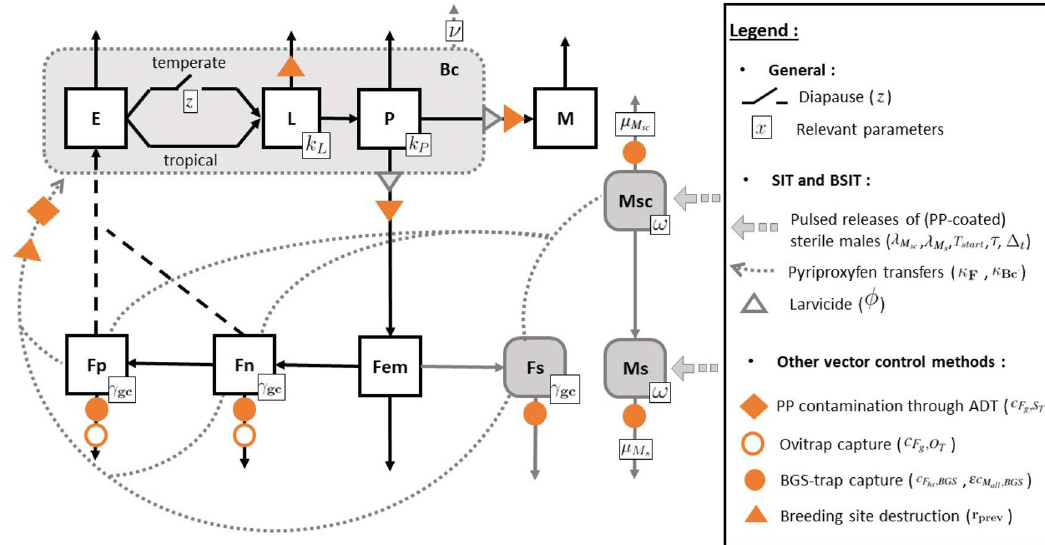
Figure 1. Simplified diagram of the model. The Aedes albopictus life cycle is computed in 7 stages: 3 are aquatic stages present in the breeding sites, eggs ( E ), larvae ( L ) and pupae ( P ), 4 are adult aerial stages, males ( M ), emerging females ( F em ), nulliparous females ( F n ) and parous females ( F p ). Black arrows indicate transitions between stages. Diapause only occurs in the temperate climate and depends on the z parameter. Changes resulting from SIT and BSIT are indicated by grey lines and boxes representing sterile males, whether PP-coated ( M sc ) or not ( M s ), sterile females ( F s ) and contaminated breeding sites ( B c ). The key parameters, in particular those affected by vector control actions, are: k L and k P respectively the larval and pupae carrying capacities, γ gc the duration of the gonotrophic cycle, ω the relative competitiveness of sterile males, µ M and µ M the mortality sc s of sterile males, respectively PP-coated or not, ν the breeding site PP decontamination rate, and φ the probability for PP-exposed larvae to survive and pupate. Additional vector control actions were added to the model (orange): mass trapping (full circles for BGS-traps and hollow circles for ovitraps) according to the probability of , ǫ c capture (respectively c F M all , BGS and c F g , O T ), prevention (triangles) by reduction of breeding sites ( r prev ), hs , BGS and PP autodissemination (diamonds for ADT) which depends on females contamination ( c F g , S